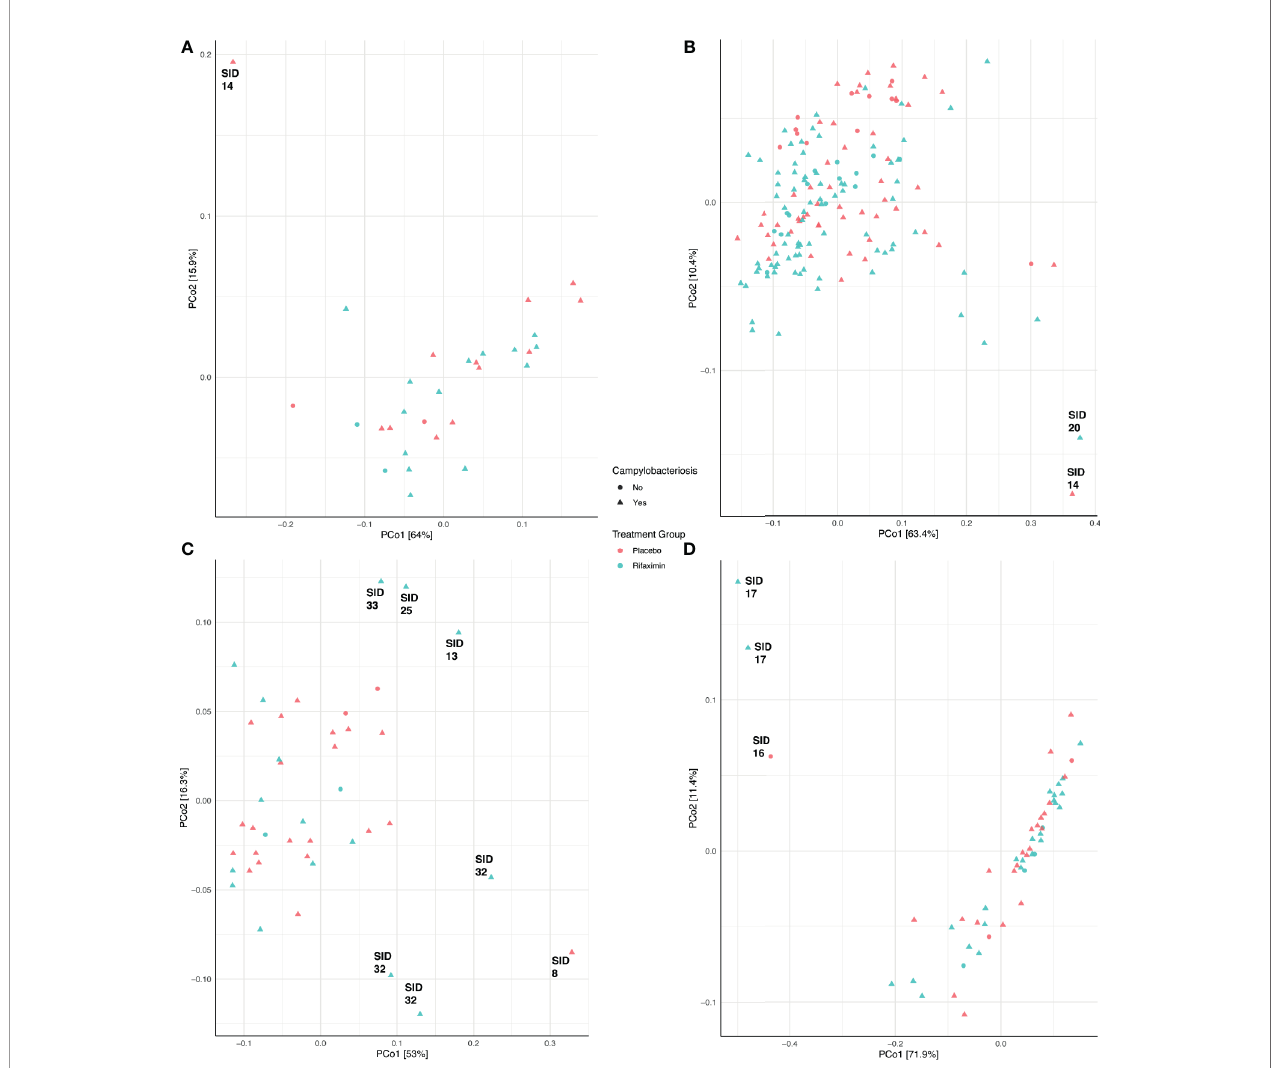
FIGURE 3 | Principal coordinate analysis (PCoA) of samples during the pre-challenge (A) , inpatient (B) , post-antibiotic administration (C) , and post-discharge (D) periods. Each PCoA was generated from a weighted UniFrac distance matrix. Samples are colored by treatment group (red, placebo; blue, rifaximin), and sample shape denotes samples from study participants who either developed campylobacteriosis (triangles) or did not